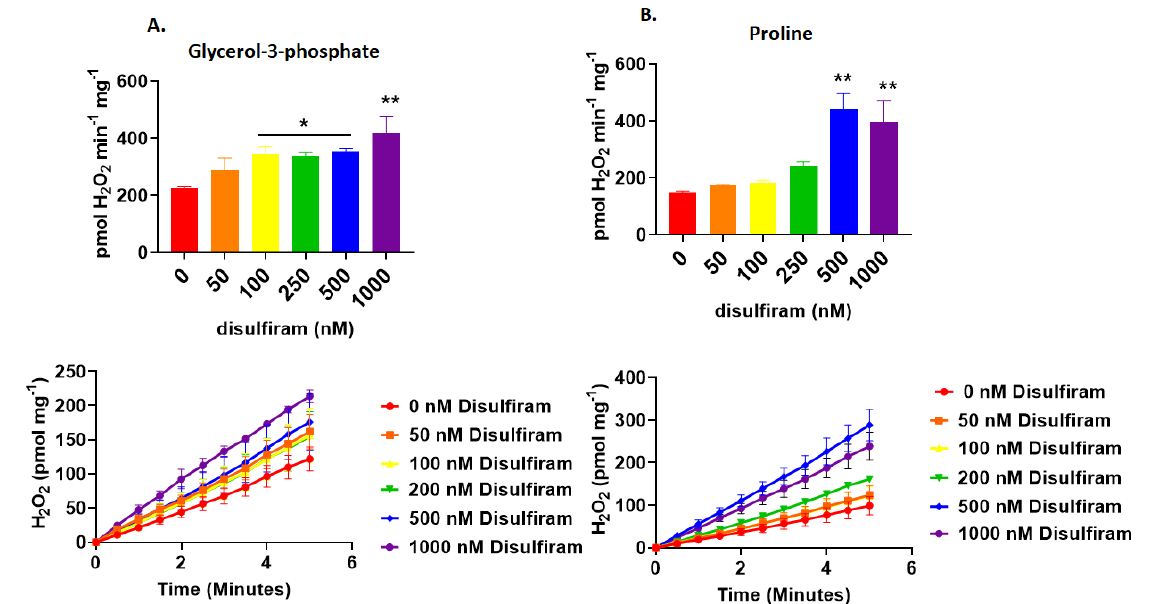
Figure 2. Chemical glutathionylation catalyst disulfiram augments O 2 • - /H 2 O 2 production by mito- chondria oxidizing ( A ) glycerol-3-phosphate and ( B ) proline. Estimates for the rate of production were determined using isolated mitochondria treated with different doses of disulfiram (0–1000 nM), 1 mM GSH, and AUR reagents. N = 4, mean ± SEM, 1-way ANOVA with a post-hoc Fisher’s